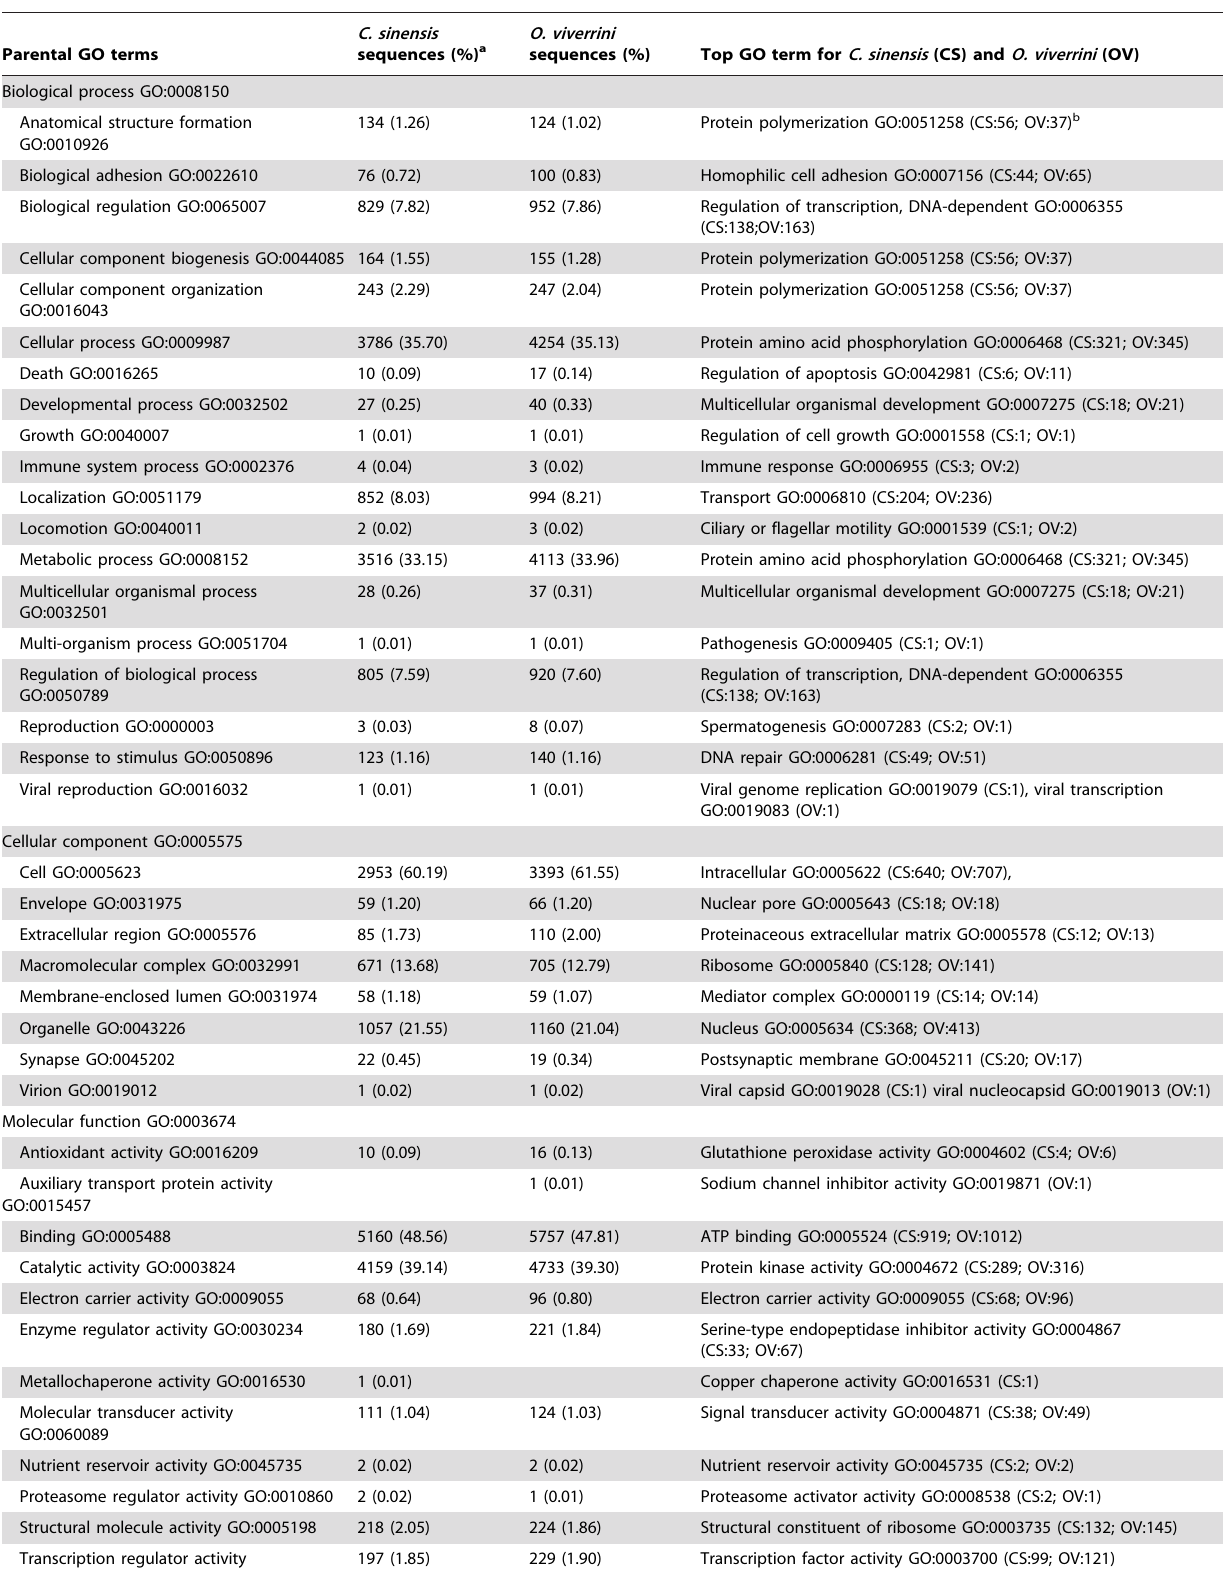
Table 6. Functions predicted for proteins encoded in the transcriptome of the adult stage of each Clonorchis sinensis and Opisthorchis viverrini based on gene ontology